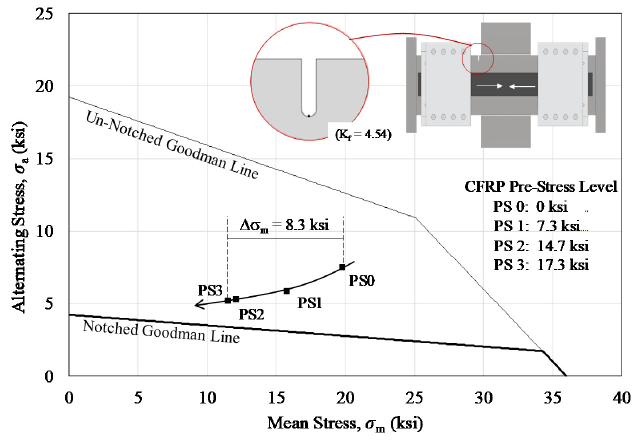
Figure 32. Effect of CFRP pre-stress level on a full-scale component stress state.